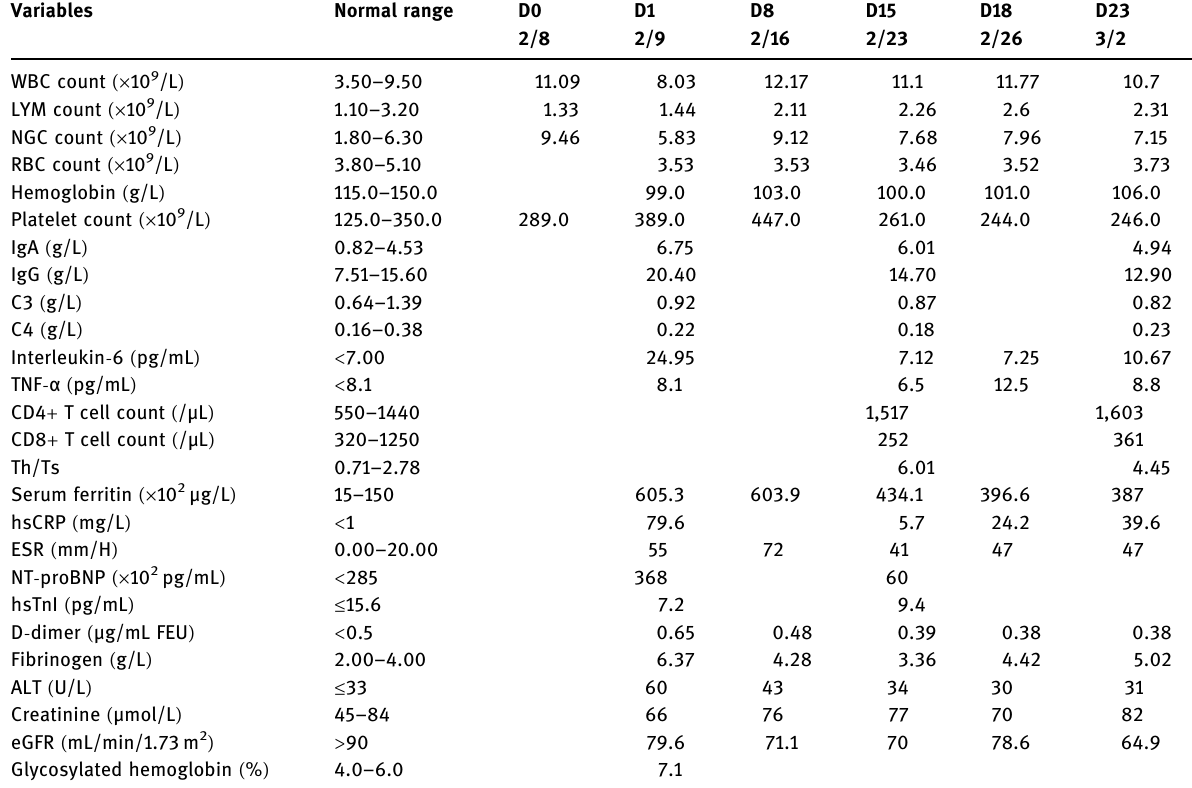
Table 1: Laboratory fi ndings. The laboratory fi ndings of the patient during hospitalization Variables Normal range